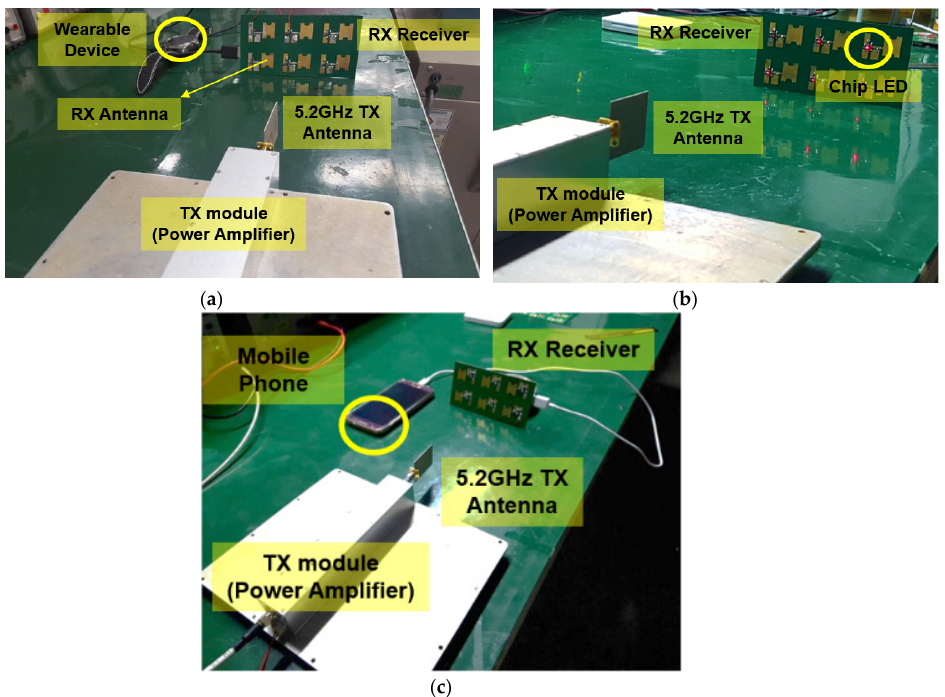
Figure 10. Test environment of the proposed RF EH ( a ) The Rx receiver board is connected to a G watch, ( b ) Chip LED, and ( c ) Mobile phone. Reprint with permission [4775431338148]; 2020, IEEE.